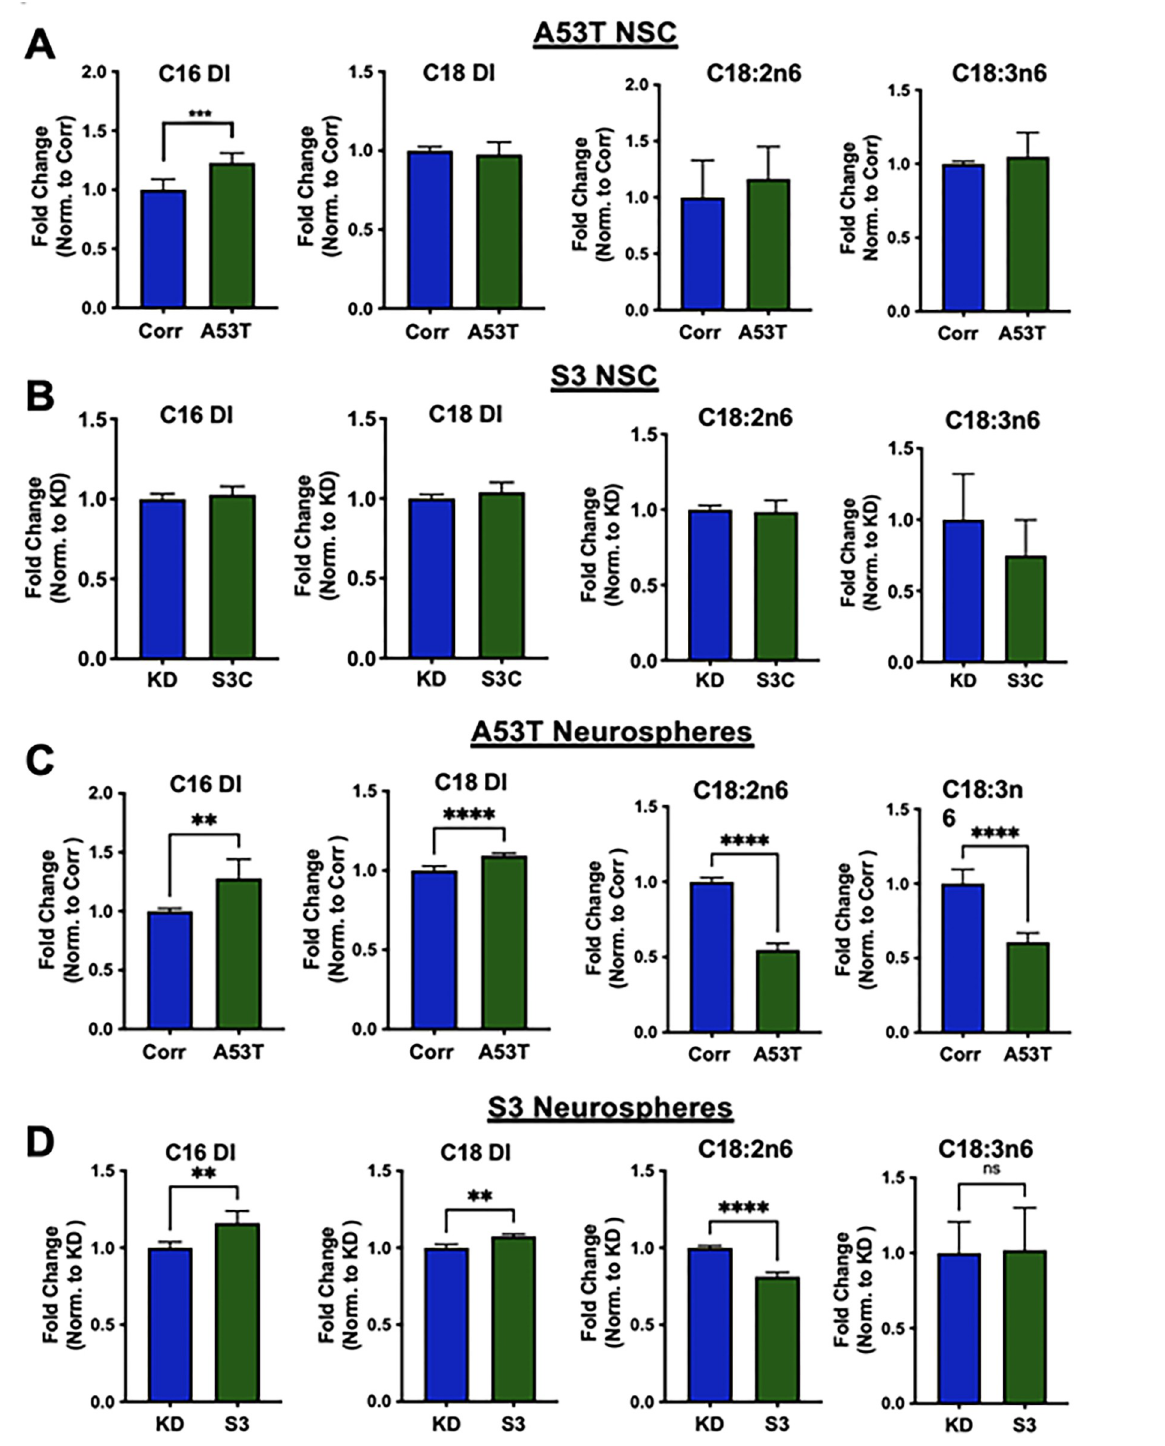
Fig 3. Fatty acid profile of NSC and neurospheres. Desaturation index (DI) for C16 (C16:1n7/C16:0) and C18 (C18:1n9/C18:0) along with the relative levels of the essential fatty acids, linoleic (C18:2n6) and γ -linolenic acid (C18:3n6), for the A53T/Corr NSC (A ) and S3/KD NSC and (B), for the A53T/Corr neurospheres (C ) S3/KD neurospheres (D) at day 54. The analysis was conducted using an unpaired two-tailed Student’s t-test, with n = 6 for (A) and n = 5 for (B). The analysis for the neurospheres was conducted using an unpaired t-test, with data from three different neurosphere differentiations. Each differentiation has two biological replicates (total 6 biological replicates). Data is mean + standard deviation and analyzed by a two-tailed Student’s t-test. ( � P < 0.05; �� P < 0.01; ��� P < 0.005; ���� P < 0.0001). https://doi.org/10.1371/journal.pone.0277532.g003 PLOS ONE | https://doi.org/10.1371/journal.pone.0277532 December1, 2022 7 /